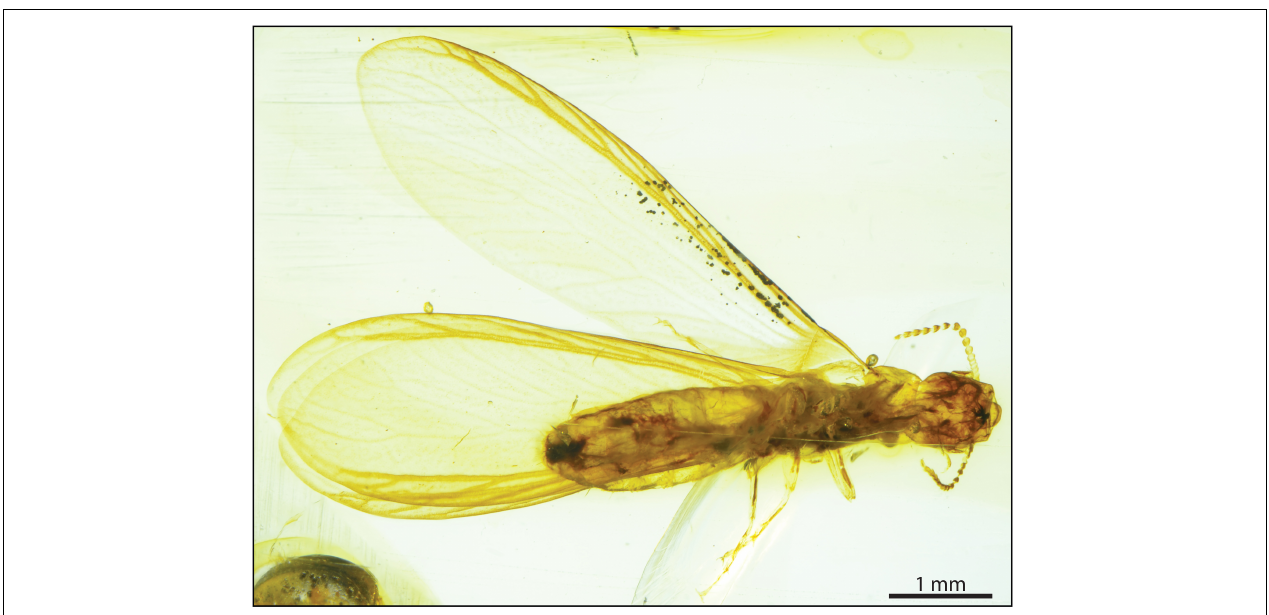
FIGURE 1 | Termite valkyrie from early Cenomanian amber. Valkyritermes inopinatus gen. et sp. nov., Kachin amber ( ca . 98 Ma,